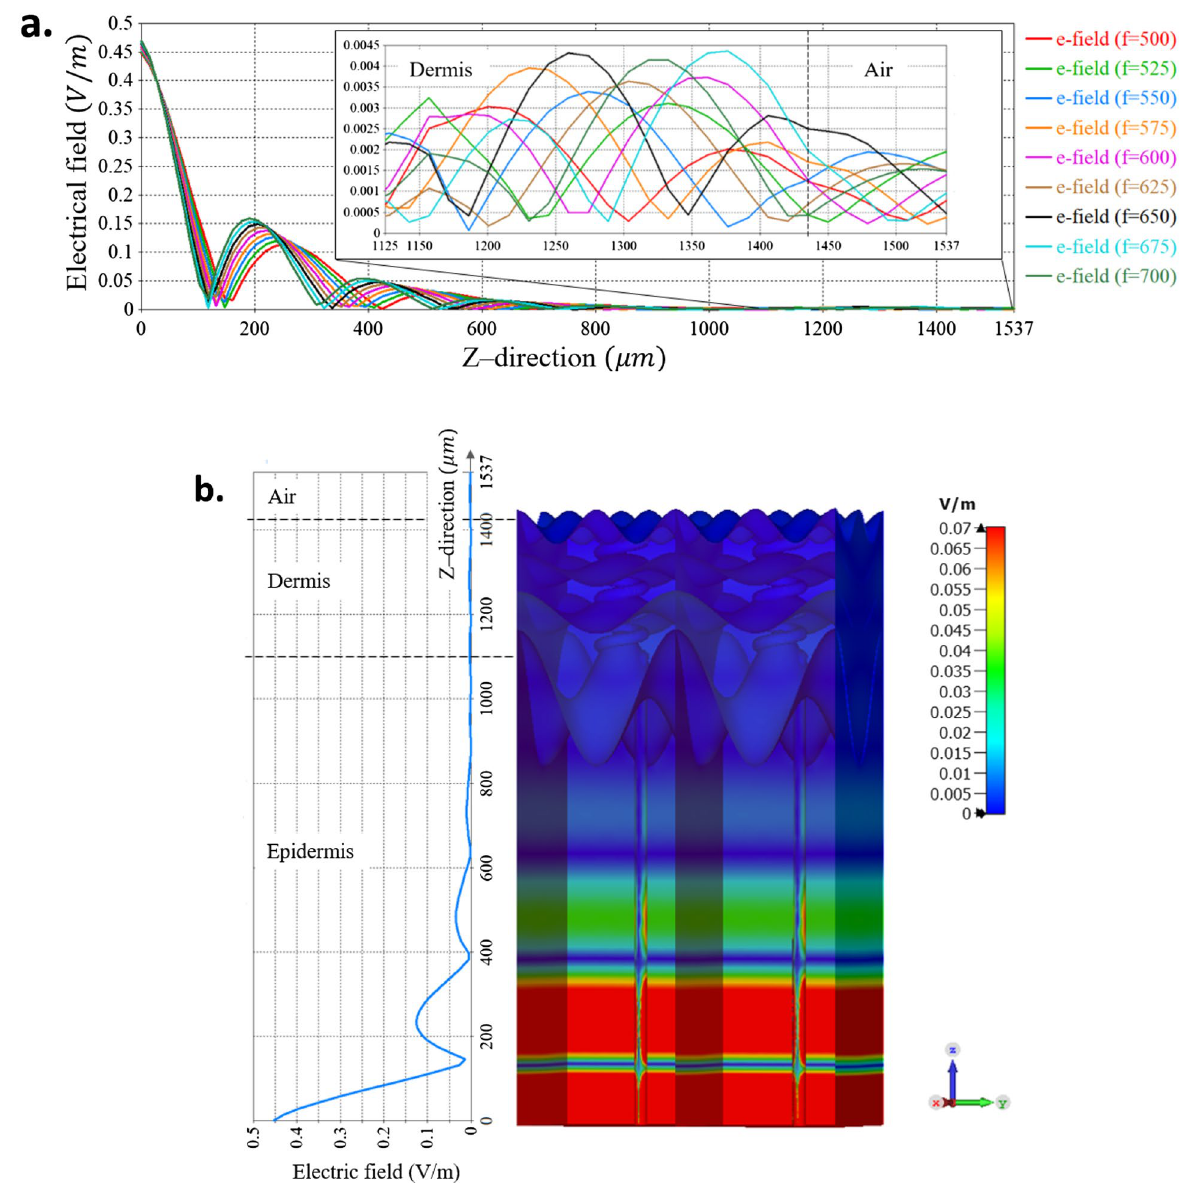
Figure 9. ( a ) The electrical field as function of distance in Z direction, i.e., throughout the skin model, for a fixed phase 145° and 9 different frequencies. ( b ) The electric field as function of the z-axis next to the 3D human skin model, for a perspective. This figure was generated using CST STUDIO SUITE v2021 30 , https:// www. 3ds. com/ produ cts- servi ces/ simul ia/ produ cts/ cst- studio- the skin surface at L = 1,537 μm. The value of the input field, E o , can be estimated inside the skin from the defini- 3 V / m for a port power P = 5 nW, once the impedance mismatch at the 10 tion of the simulation as E o ∼= 1.3 − ×